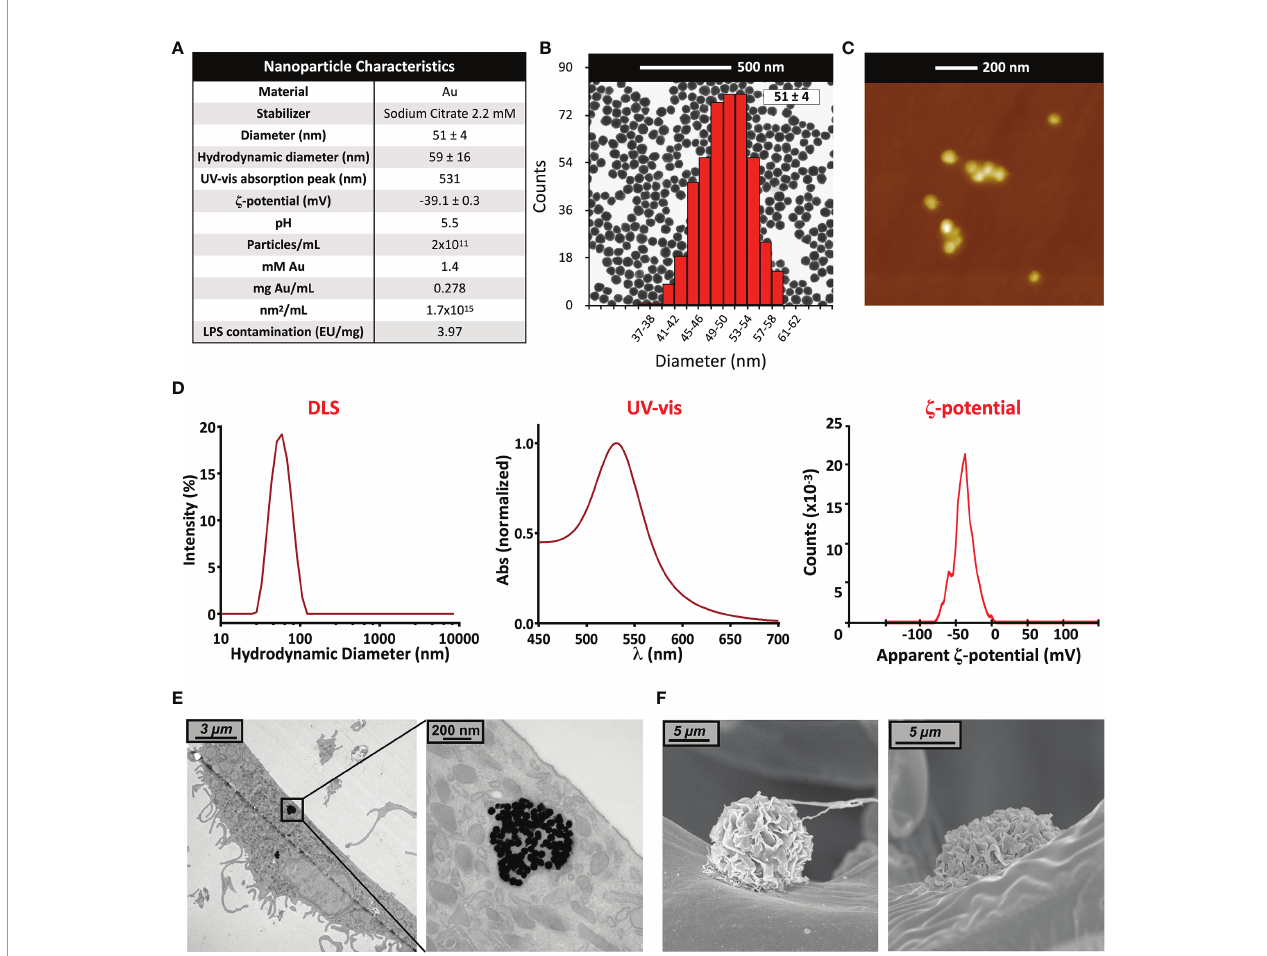
FIGURE 1 | Gold nanoparticle characterization. (A) Summary of characteristics of the AuNP batch used in this study; (B) TEM image and size distribution (calculated via ImageJ); (C) Atomic Force Microscopy image; (D) UV-vis spectrum, hydrodynamic size distribution calculated by DLS, and z -potential; (E) TEM and (F) SEM images of human primary monocytes, pre-exposed to AuNP for 24 h and then cultured for 6 additional